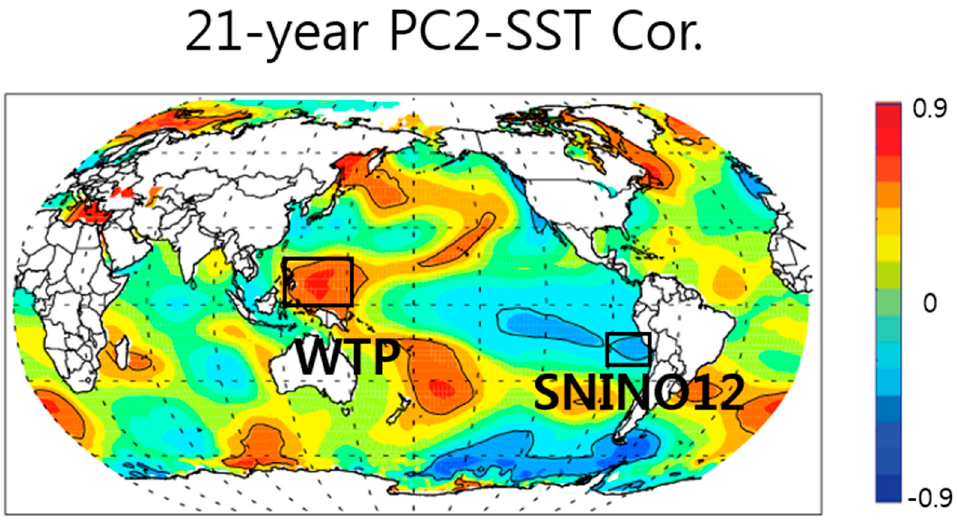
Figure 7. Twenty-one-year (1995–2015) correlation map of PC2 and SST. Black solid lines indicate significance at the 95% confidence level.